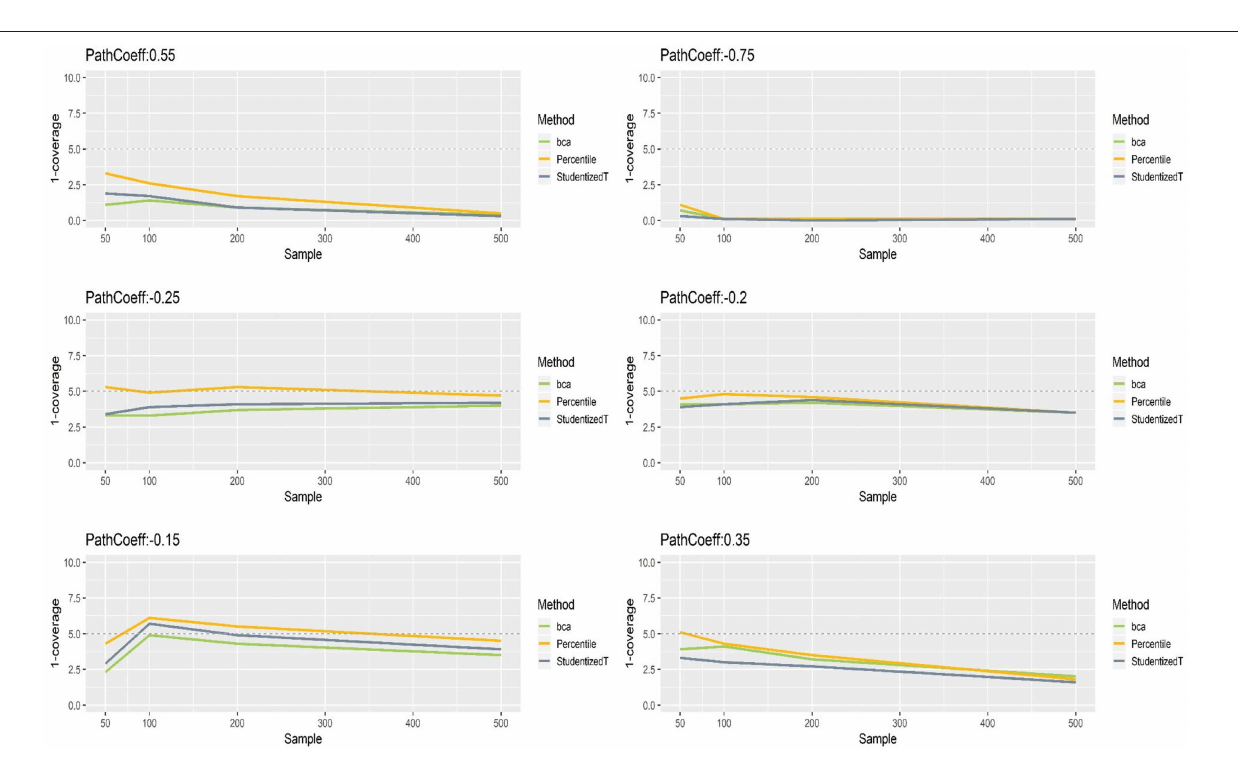
Frontiers in Psychology |